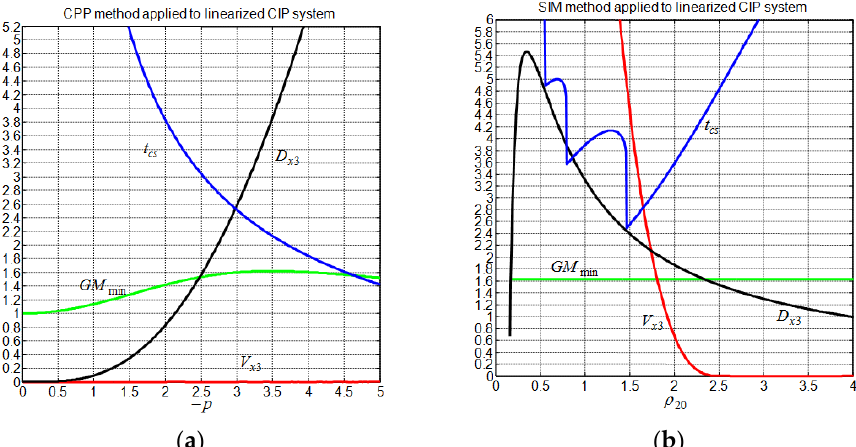
Figure 10. Evolution of the system gain margin and the cart response performance. ( a ) CPP method; ( b ) SIM method.